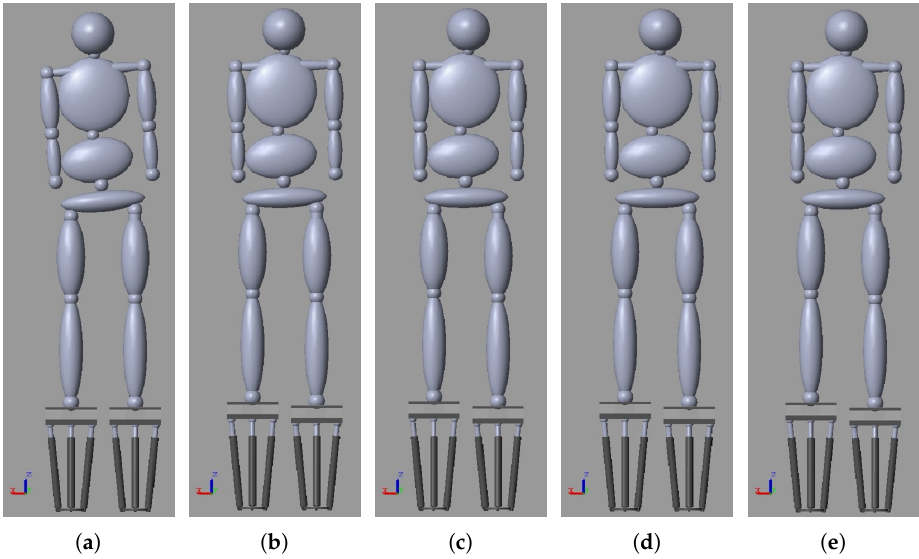
Figure 12. Scenario 2: ( a ) Initial state of the human body with LLD and scoliosis (algorithm iteration k = 0); ( b ) algorithm iteration k = 1; ( c ) algorithm iteration k = 2; ( d ) algorithm iteration k = 3; and ( e ) the human body with LLD and scoliosis is balanced (algorithm iteration k = 4).